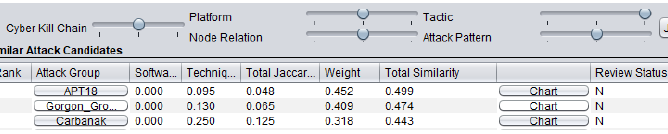
Figure 14. Result of the similarity metric (with one feature weighted more than the others).